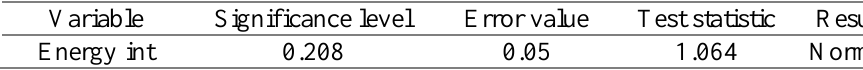
Table 5. Results of Kolmogorov- Smirnov Test